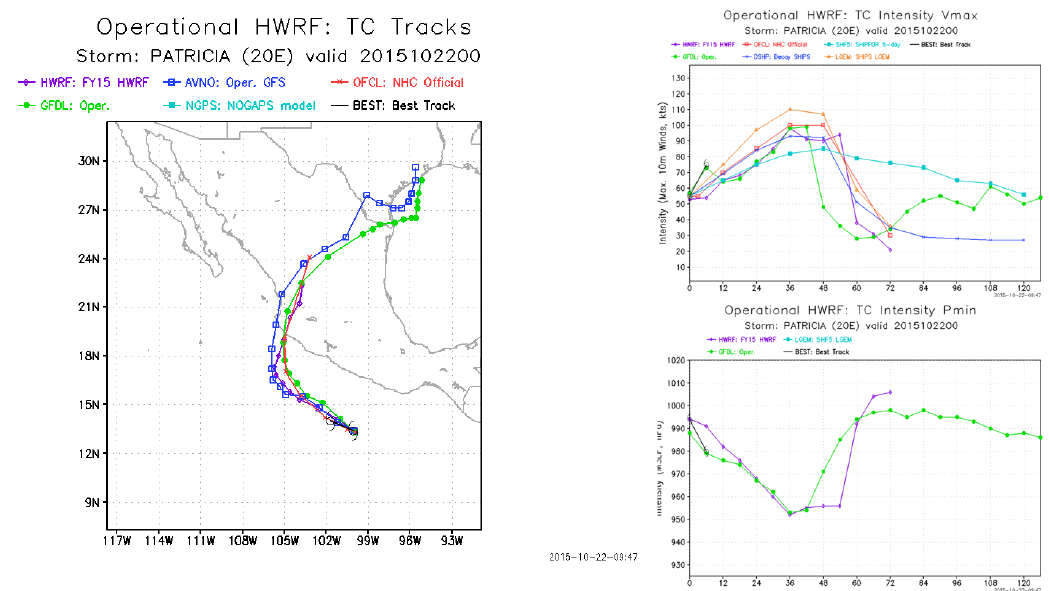
Figure 4. Forecast products available at 0000 UTC 22 October 2015 to the operational community for Hurricane Patricia. The left -hand side diagram is the track prediction for Hurricane Patricia, the right- hand side is the maximum wind speed ( upper ), and the central pressure ( lower ).